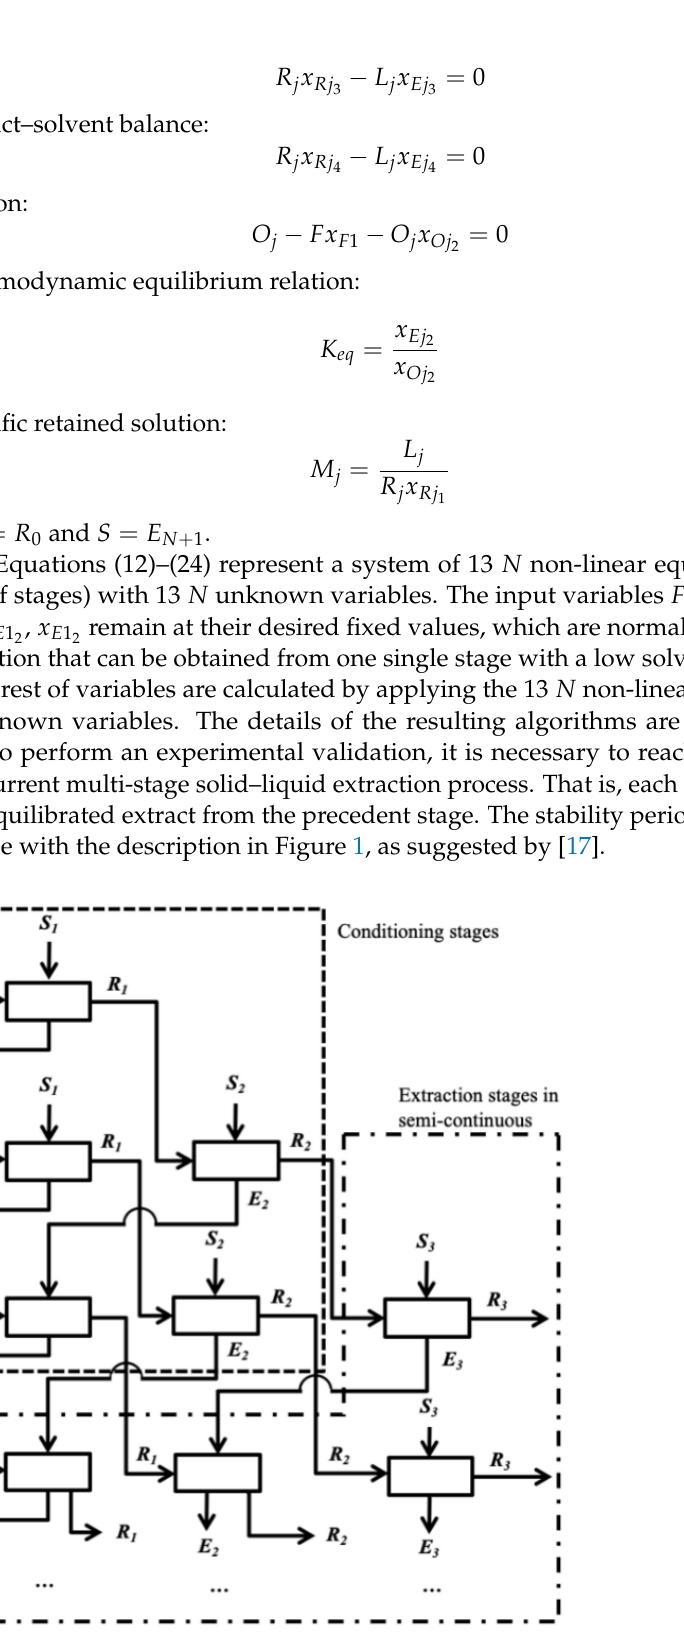
Figure 1. Counter-current multi-stage extraction start-up [15].